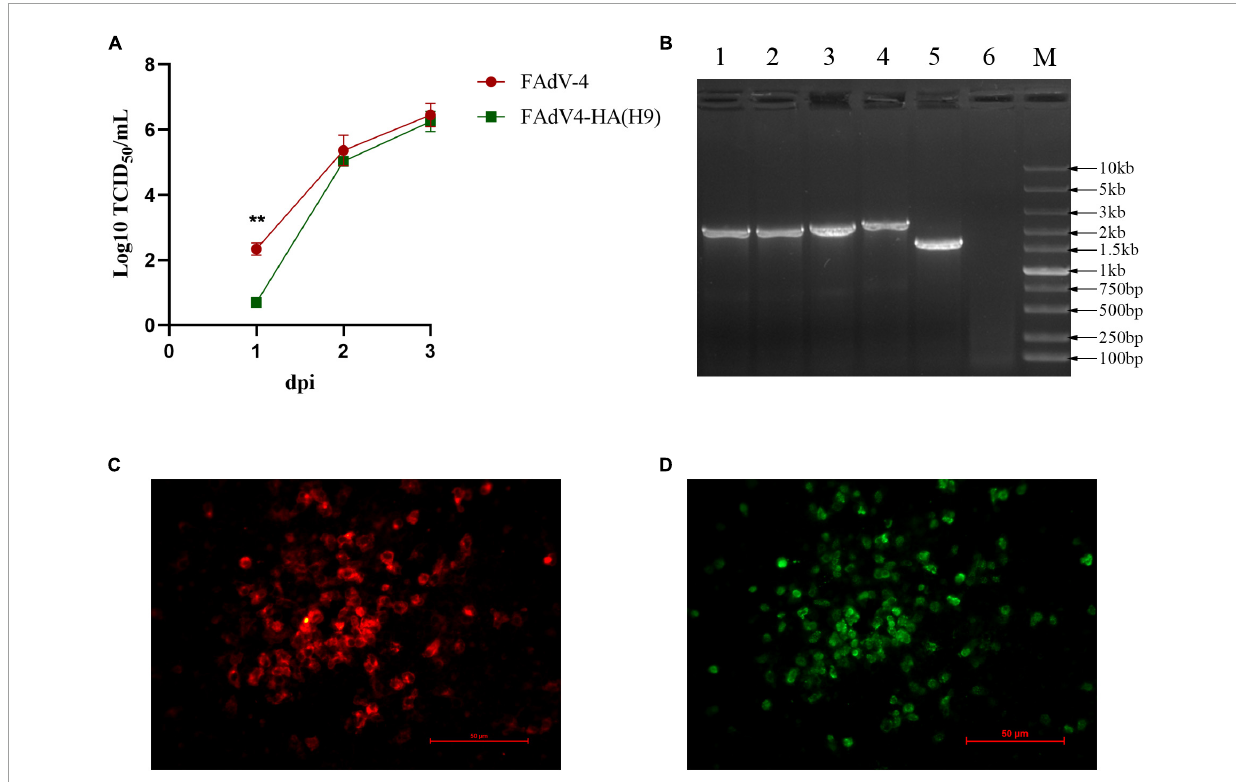
FIGURE4 Growth curve and stability of the recombinant virus FAdV4-HA(H9). (A) LMH cells were infected with FAdV4-HA(H9) and FAdV-4 at the same dose, respectively, the viral supernatant collected from the infected LMH cells at the indicated time points were then titrated by TCID 50 . This experiment was done in triplicate and repeated twice. Statistical analysis in this experiment was performed with a Student’s t -test using GraphPad Prism 8 software. (B) PCR analysis of the recombinant virus FAdV4-HA(H9) at every 5 passage. lane 1-6 represent passage 5, passage 10, passage 15, parental virus FA4-EGFP, wild-type FAdV-4 and negative control, respectively. IFA analysis for the expression of HA in FAdV4-HA(H9) at passage 15 using mAb 2G10 against HA of H9N2 (C) and chicken serum against FAdV-4 (D) . These experiments were performed twice with comparable results.